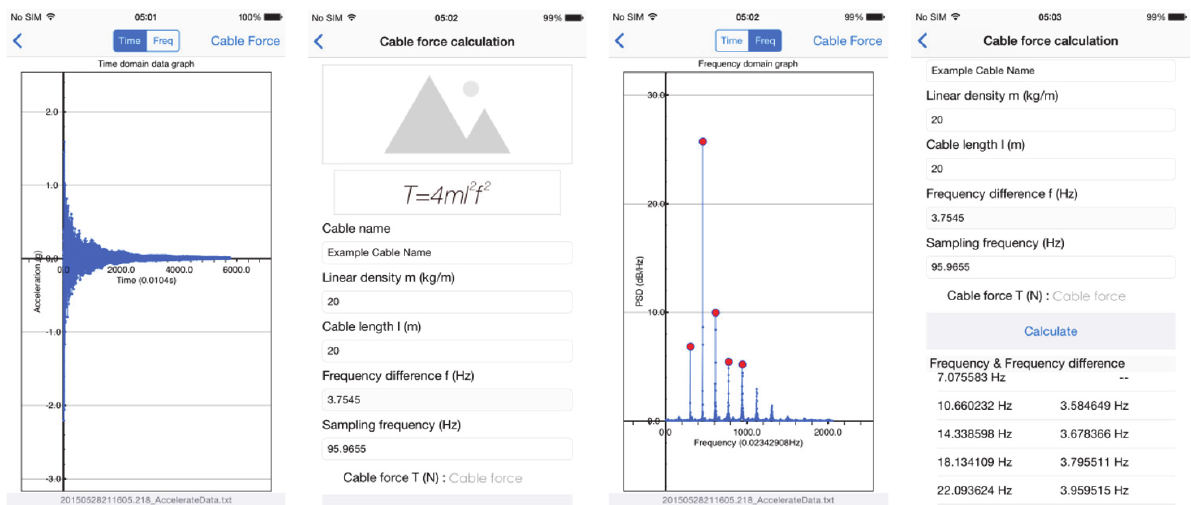
Figure 5: Main function interface of cable force